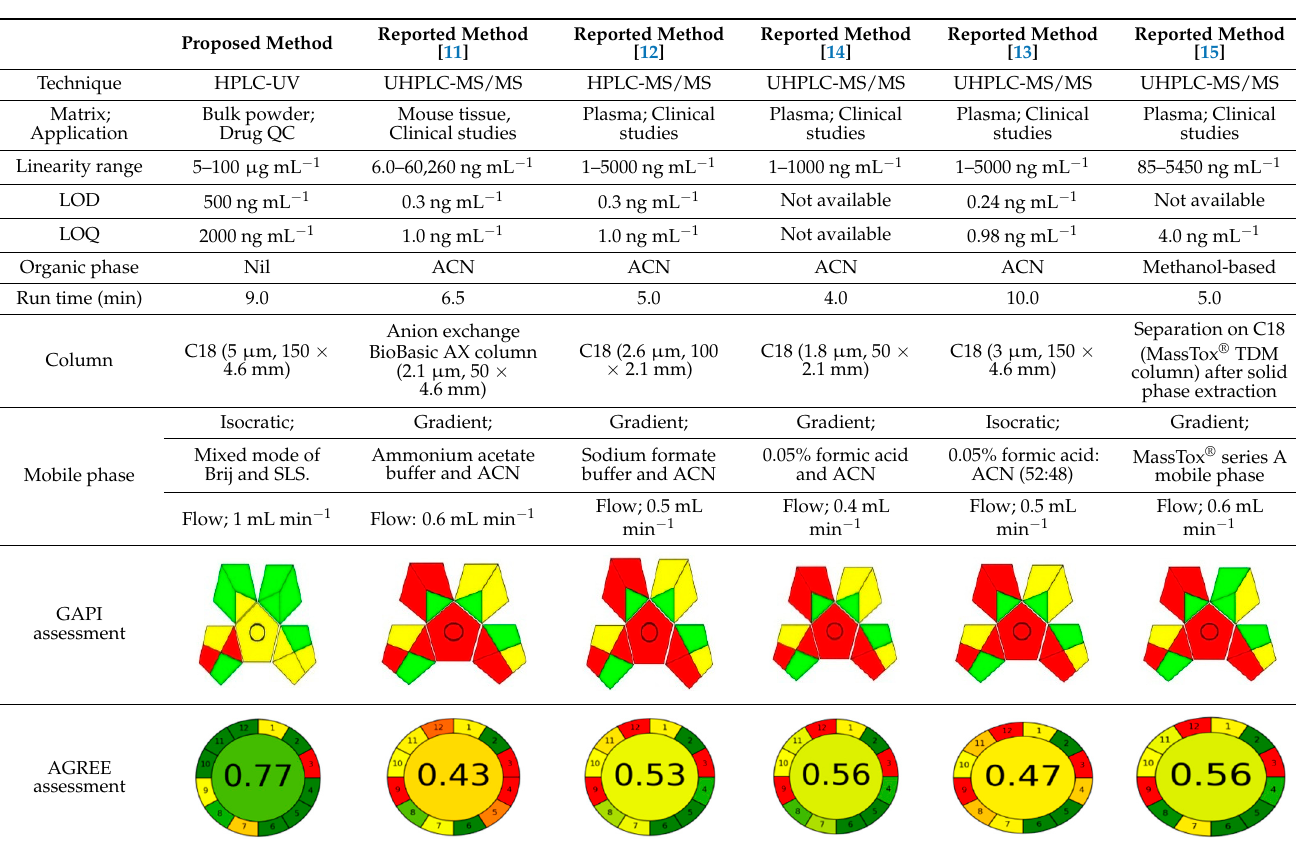
Table 4. Comparison of the proposed analytical methods to chosen reported